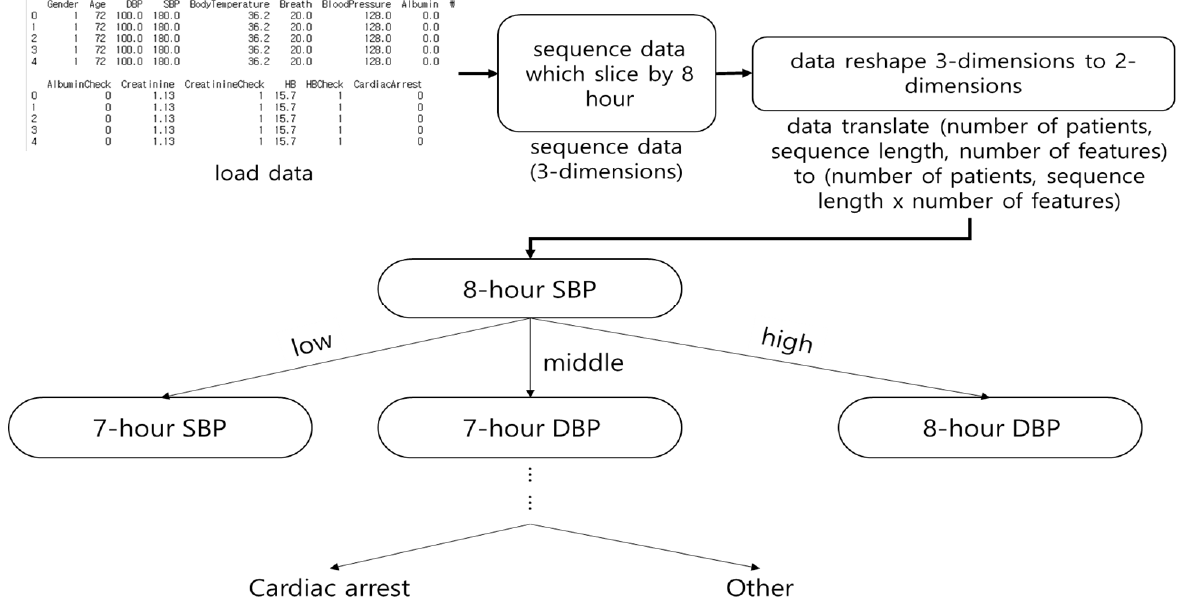
Figure 1. The process of cardiac arrest prediction: (1) data collection from the CSV file, (2) grouping of the data, (3) division of the data into training, verification, and test data, (4) data slicing, (5) Synthetic Minority Oversampling Technique (SMOTE) algorithm was performed on the training data, and (6) the machine learning algorithm.